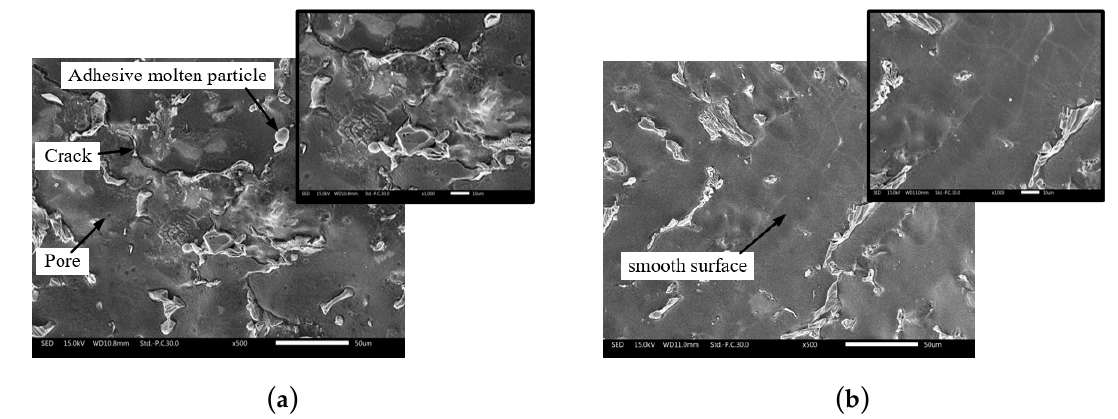
Figure 18. The morphologies of hole wall processed by the different electrodes: ( a ) Cylindrical tube electrode; ( b ) helical tube electrode.